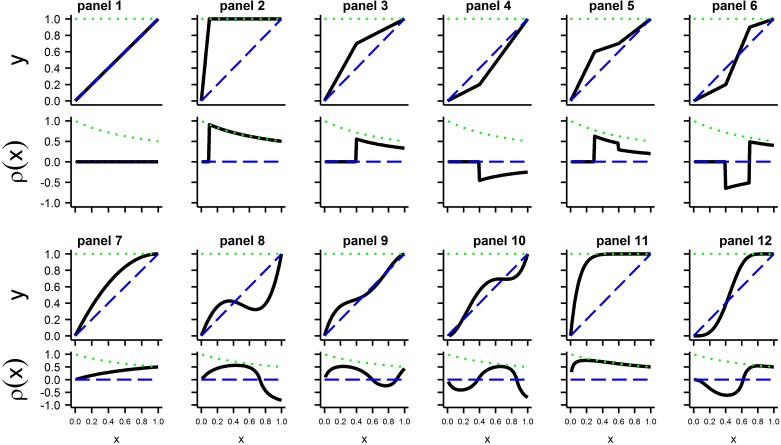
Each panel contains the hypoxia plot on top and the matching regulation profile below.The blue dashed line is the curve for a non-regulator and the green dotted line is the curve for a perfect regulator. The 12 panels contain the following models: (1) S1 (a non-regulator), (2) S2 with Pt = 0.1, (3) S3 with Pt = 0.4, Vt = 0.7, (4) S3 with Pt = 0.4, Vt = 0.2, (5) S4 with Pt1 = 0.3, Vt1 = 0.6, Pt2 = 0.6, Vt2 = 0.7, (6) S4 with Pt1 = 0.4, Vt1 = 0.2, Pt2 = 0.7, Vt2 = 0.9, (7) Polynomial with b0 = 0, b1 = 2, b2 = -0.99, b3 = -0.01, b4 = 0, (8) Polynomial with b0 = 0, b1 = 2.6, b2 = -4, b3 = -1.1, b4 = 3.5, (9) Polynomial with b0 = 0, b1 = 3.333, b2 = -10.222, b3 = 14.222, b4 = -6.333, (10) Polynomial with b0 = 0, b1 = 0.1, b2 = 9.2, b3 = -17.5, b4 = 9.4, (11) C2 with Pp = 0.1, (12) C3 with Pp = 0.5, Vp = 0.3.